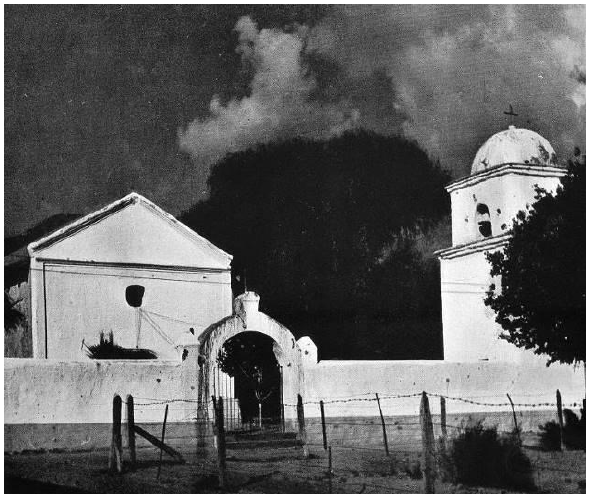
Figure 3. The Church of Uquía in a photograph from 1939 © Academia Nacional de Bellas